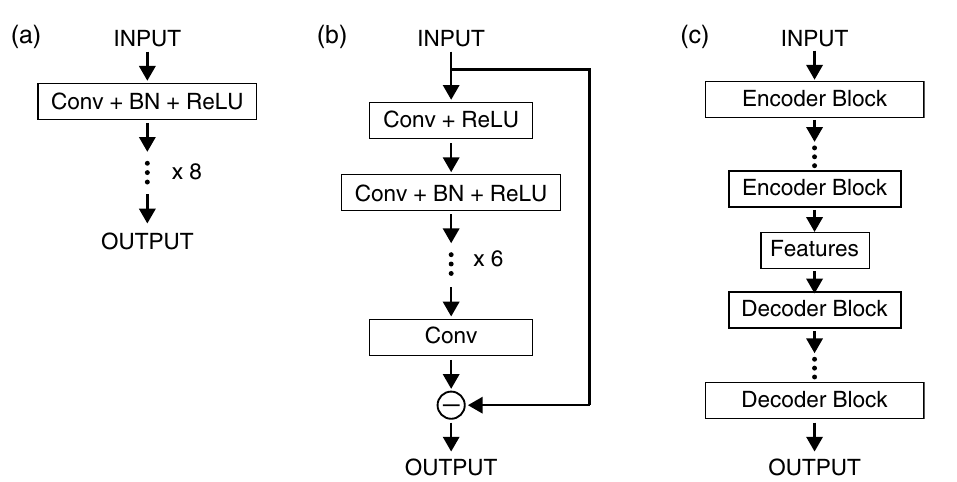
Figure 1. Simulated NR data at the incidence angle of 0.3 2500, and 1000 ( a ) and depth distribution of SLD ( b ) for a 100-nm-thick film with SLD of 7.1 × 10 The blue filled circles and green curves in ( a ) represent the simulated NR and ground truth data, respectively.